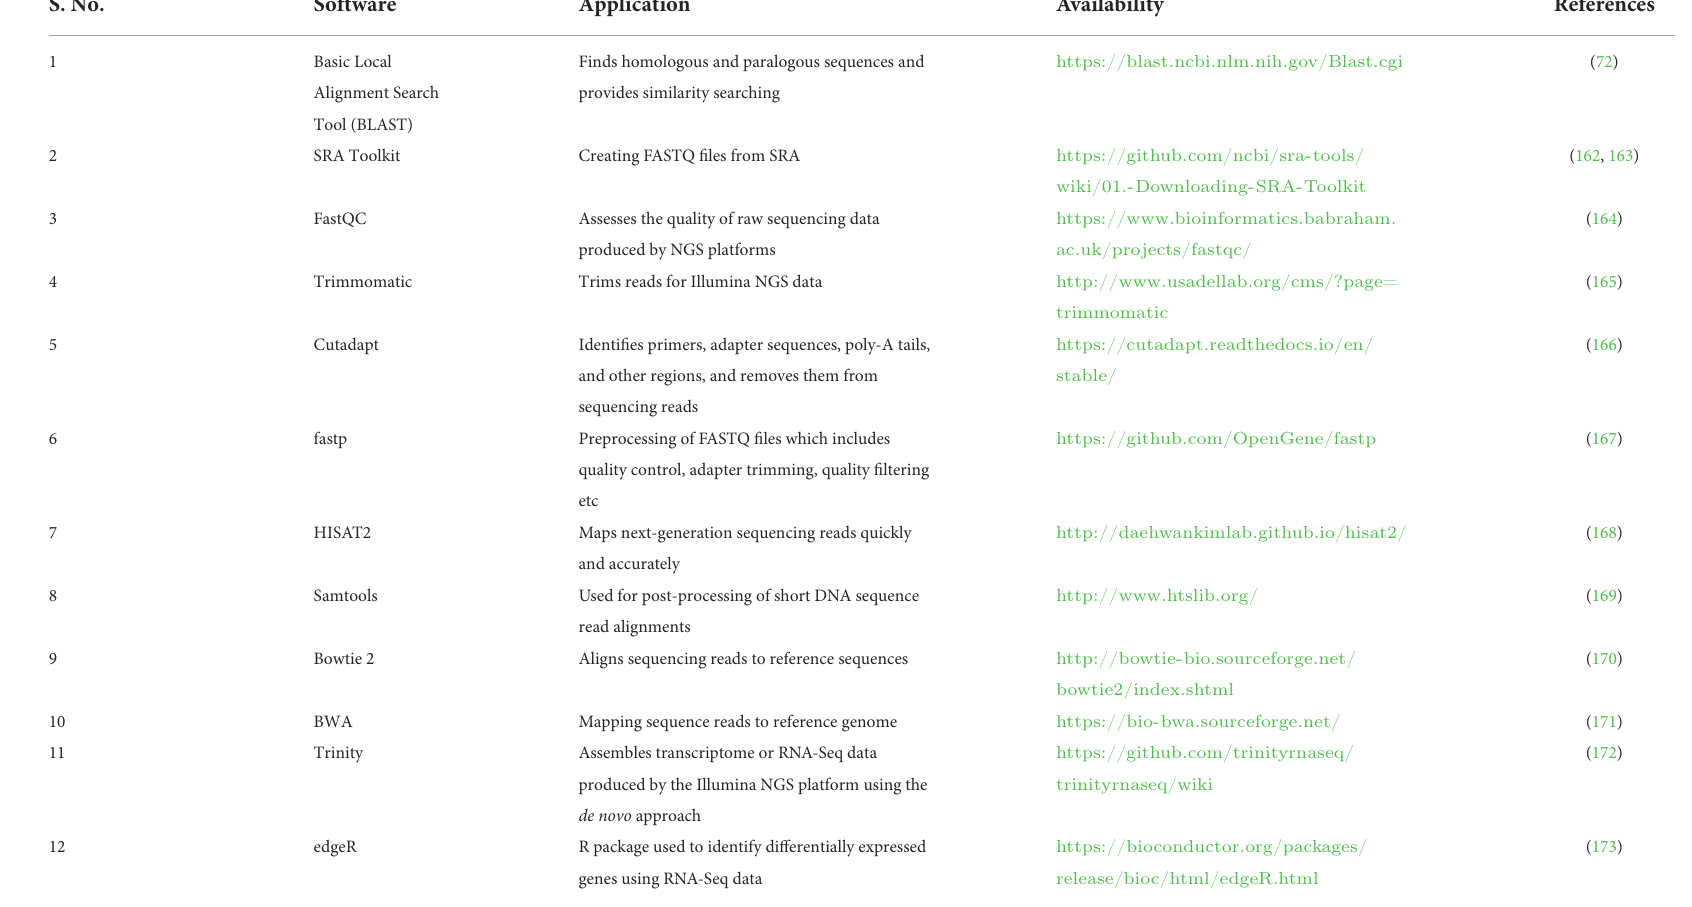
TABLE 2 A list of popular computational software available for livestock research. S.